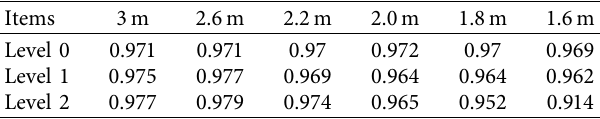
Table 5: Test results of beam bridge (tailwind, bottom).